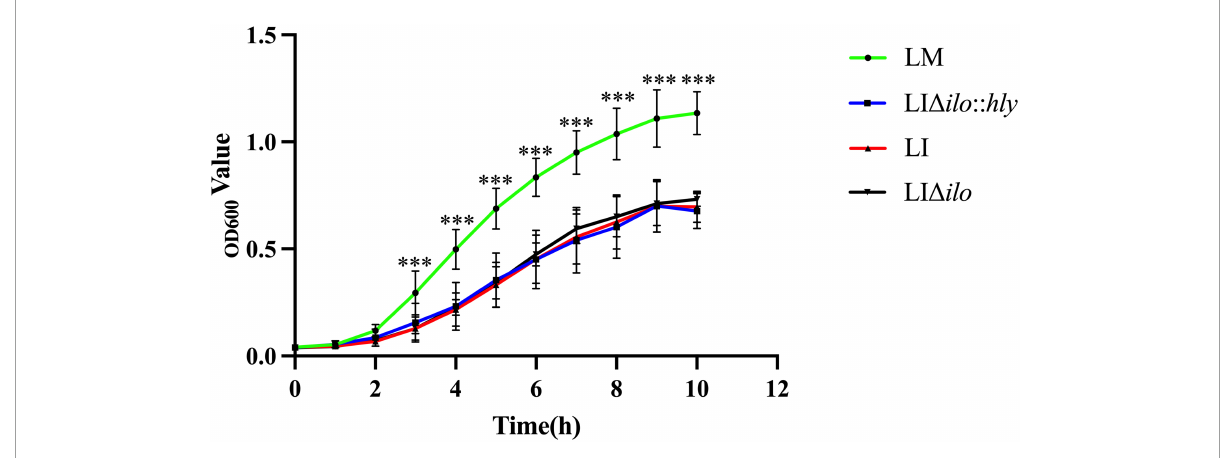
FIGURE1 The growth curves of the strains. ∗∗∗ P < 0.001 vs. Listeria monocytogenes (LM). Experiments were carried out at least three